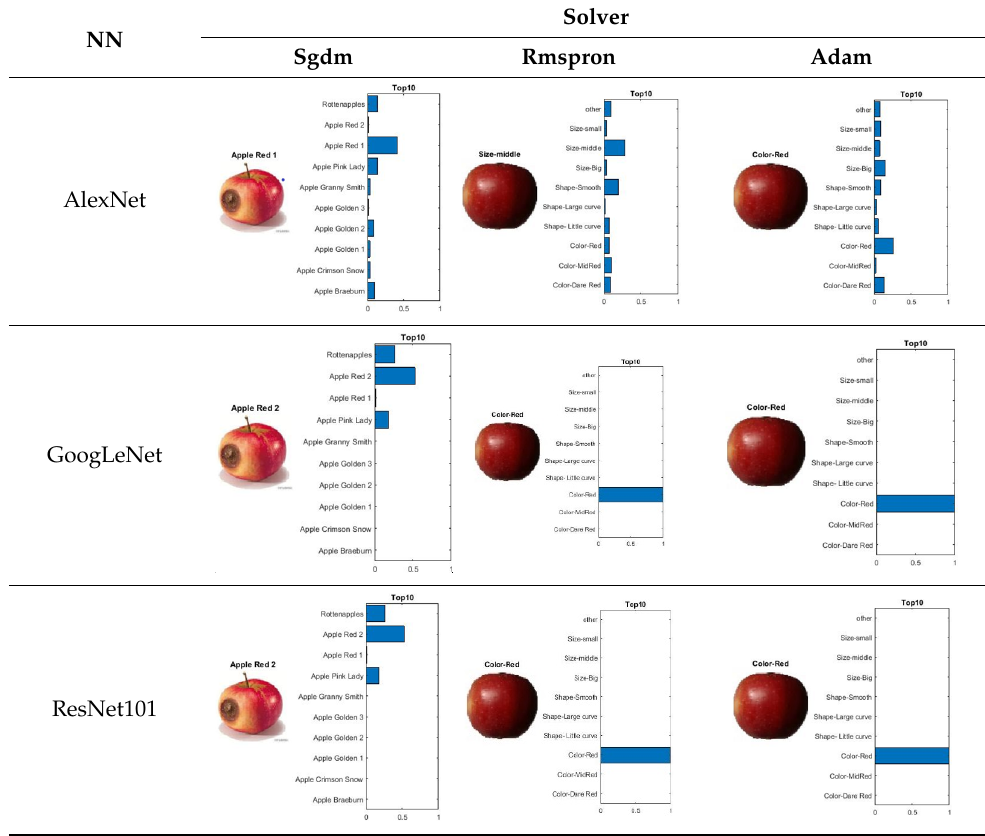
Table 7. The sequential results from the testing activity.